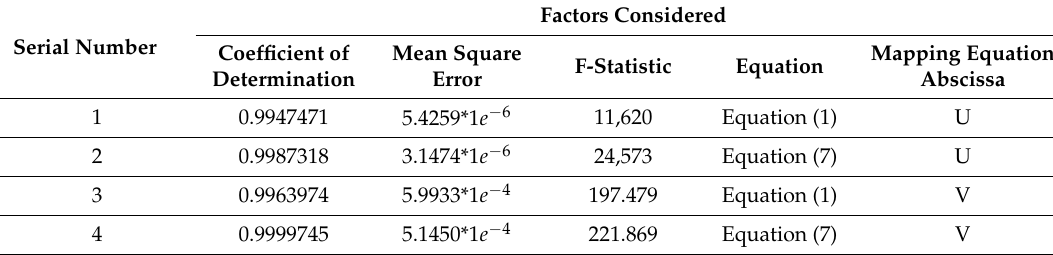
Table 2. Regression fitting of abscissa and ordinate in the two equations (Serial numbers 1 and 3 respectively represent the results of fitting the abscissa and ordinate of gaze points in quadratic polynomial, Serial numbers 2 and 4 respectively represent the results of fitting the abscissa and ordinate of gaze points in the mapping equation based on the homography